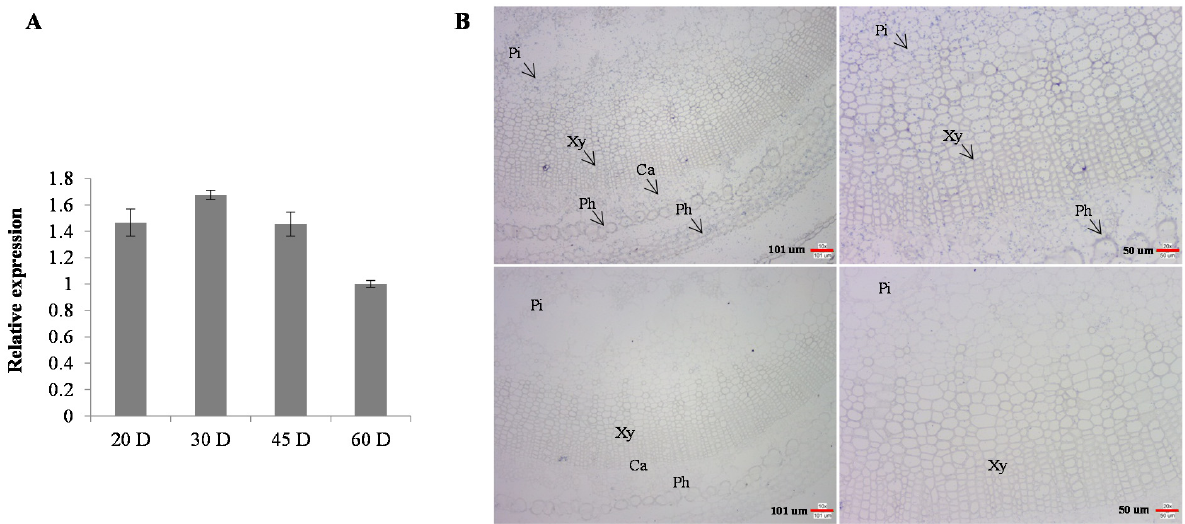
Figure 1. Expression patterns of the SlHB8 gene in tomato stems. ( A ) Quantitative reverse transcription PCR analysis of the SlHB8 gene in different development stages of tomato stem. 20 D: 20 days after germination; Error bars mean ± standard error (SE) of three biological replicates. ( B ) RNA in situ hybridization of SlHB8 in stem tissues of SlHB8 overexpression tomato plant. Stems at 6th internodes of 2-month-old tomato plants cultivated in soil were cross-sectioned for hybridization with sense (upper) and antisense (lower) probes of SlHB8 . The photos were taken under 10 × (left) and 20 × (right) microscopy. Black arrows indicate in situ hybridization signals for SlHB8 transcripts. Pi, pith; Ca, cambium; Ph, phloem; Xy, xylem. Bars: 101 um (left), 50 um (right).